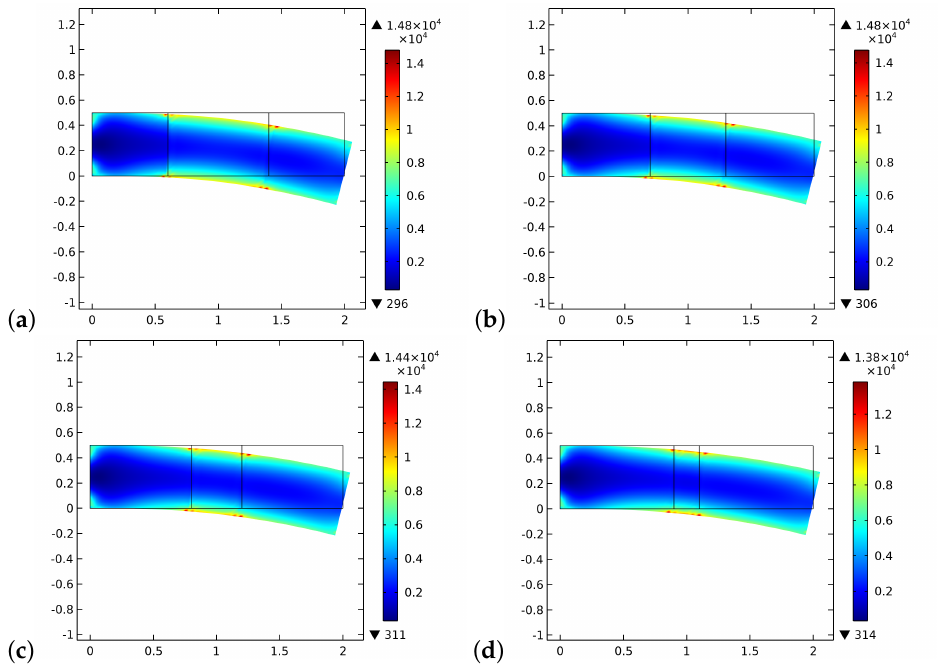
Figure 8. The distribution of the energy density E at the beginning of the time of simulation for different substitute lengths of the graft: ( a ) 0.8 cm. ( b ) 0.6 cm. ( c ) 0.4 cm. ( d ) 0.2